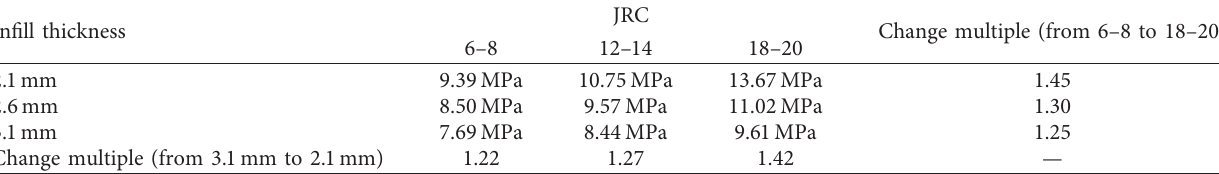
Change multiple (from 3.1 mm to 2.1mm)